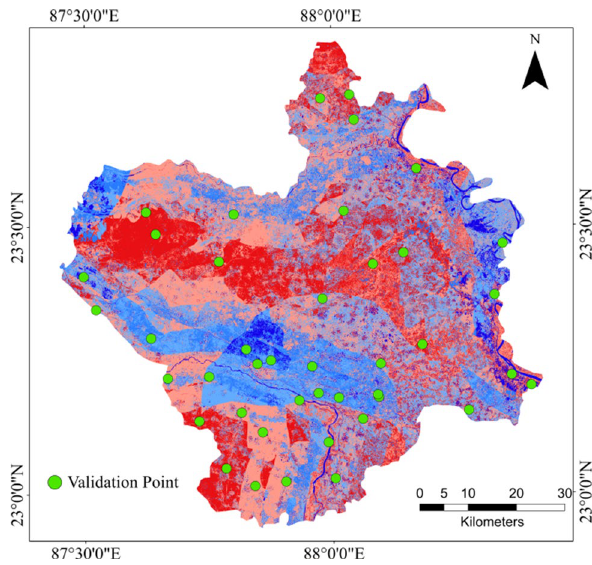
Fig. 10 Groundwater validation